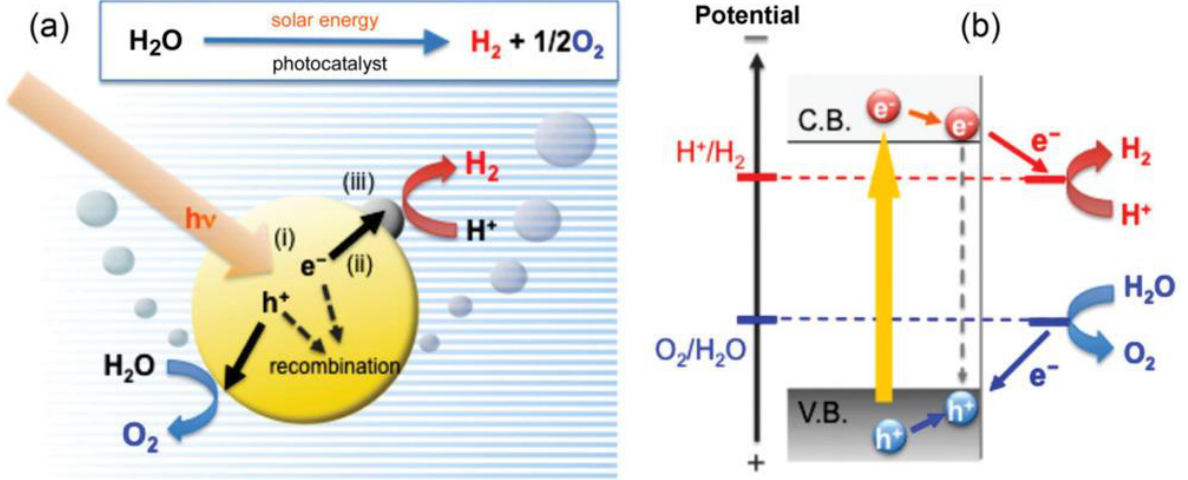
Figure 1. ( a ) Schematic representation of (i) photon absorption, (ii) charge separation and transfer and (iii) surface chemical reactions; ( b ) redox potential requirements for photoinduced water oxidation and reduction processes mediated by a semiconductor photocatalyst. Reproduced from reference [9] with permission from Elsevier, copyright 2010.